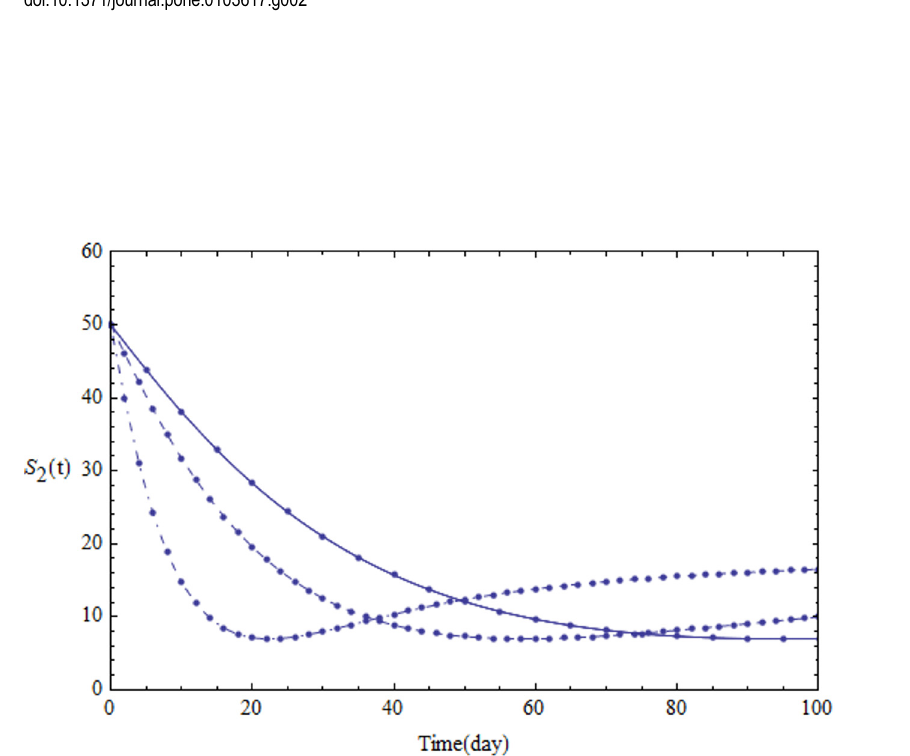
Fig 3. The population of S 3 ( t ) versus t: α = 1.0 (solid line), α = 0.95 (dashed line) and α = 0.85 (dot- dashed line).